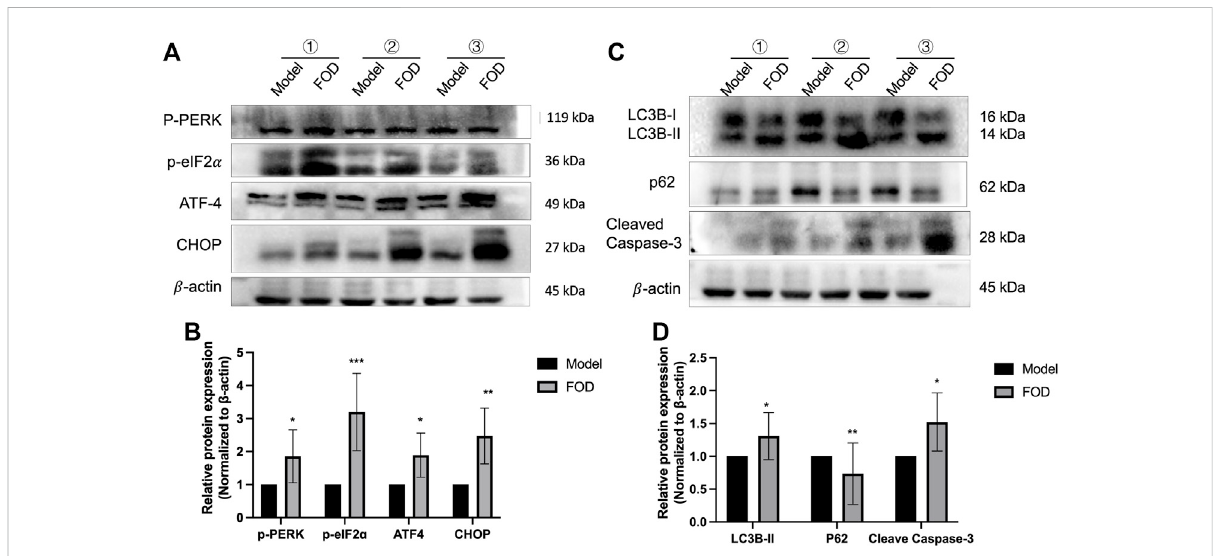
FIGURE 2 (A,B) Western blot analysis was used to evaluate the expression levels of p-PERK, P-EIF2 α , ATF4 and CHOP proteins in tumor tissues; (C,D)